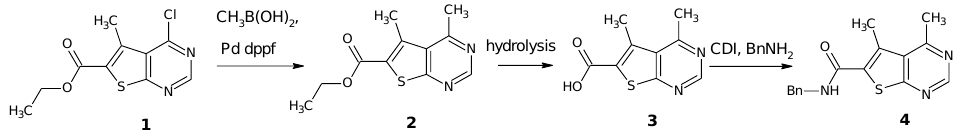
Figure 1. Synthesis of thieno[2,3-d]pyrimidine core modified with amide functional group